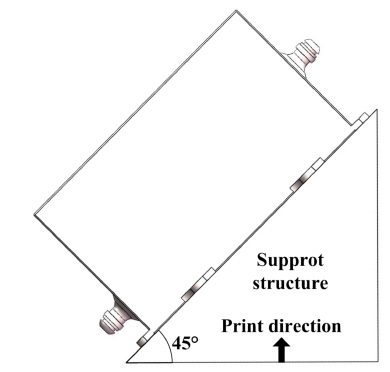
Figure 11. The print direction of the storage